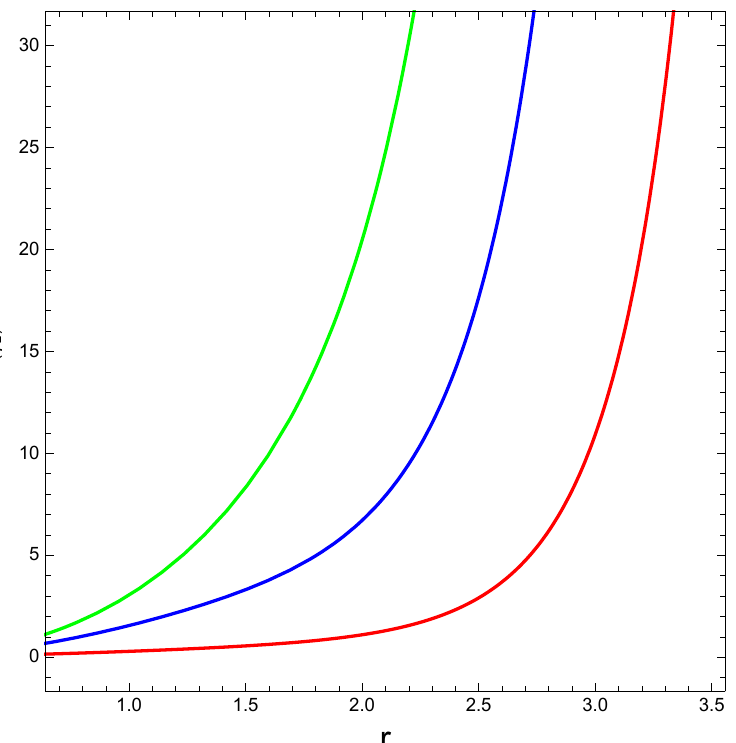
Figure 17. Solution of the scalar potential for R adopted as a linear function radius. The evolution of the scalar potential V ( φ 2 ) is obtained by comparing Equation (7) and Equation (32). We have fixed the values of η 2 , η 3 , a 0 , a 1 , a 2 , K , and C 1 . The red, green, and blue lines correspond to small perturbations of λ 0 , Ψ 0 , and η 1 ,